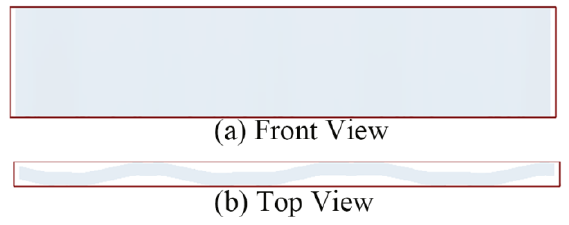
Figure 14. Morphology of the rough fracture (JRC = 10).